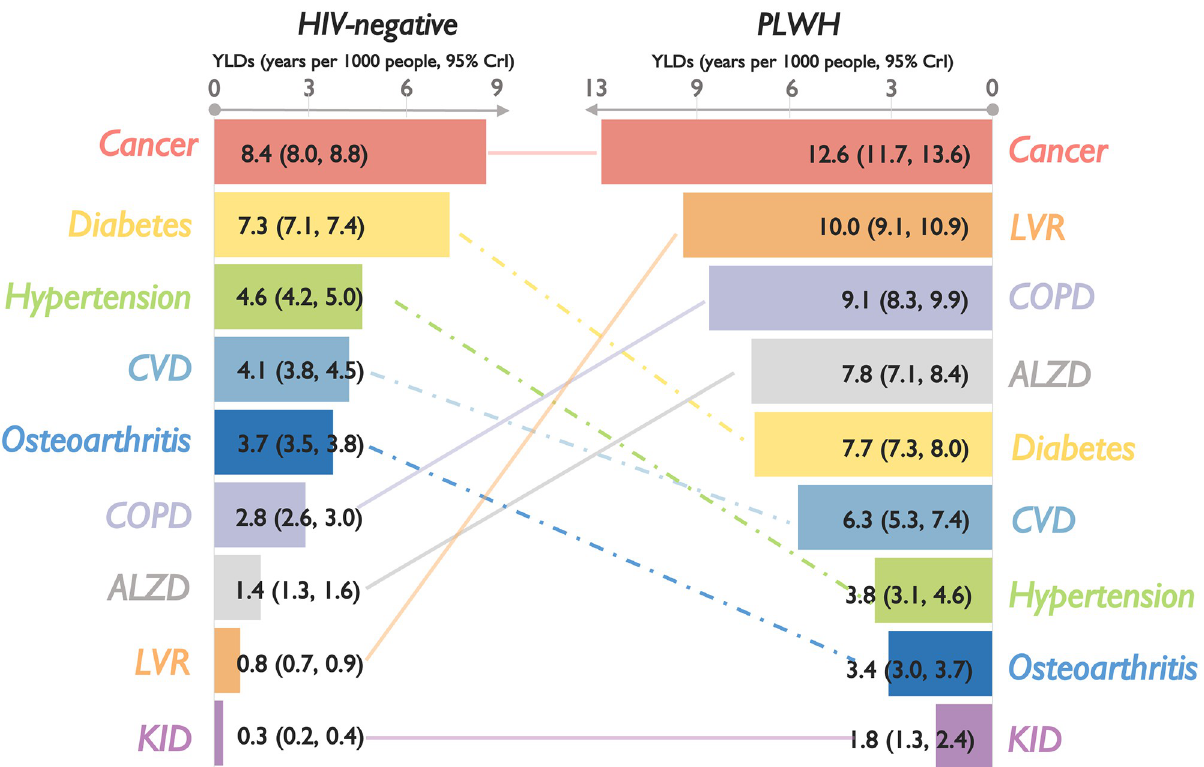
Fig 2. Cumulative YLLs (2008–2012) per 1000 people, with 95% credible intervals, associated with nine selected chronic comorbidities, ranked from highest to lowest, by HIV status in British Columbia, Canada. Note: PLWH: people living with HIV; YLLs: years life lost due to premature mortality; 95% CrI: 95% credible intervals; ALZD: Alzheimer’s and/or non-HIV-related dementia (denominator included only individuals aged 40 years and older); Cancers: non-AIDS-defining cancer; COPD: chronic obstructive pulmonary disease (denominator included only individuals aged 35 years and older); CVD: cardiovascular diseases; KID: kidney diseases; LVR: liver diseases. Horizontal scales differ for each graph and between PLWH and HIV-negative controls for illustration purposes.